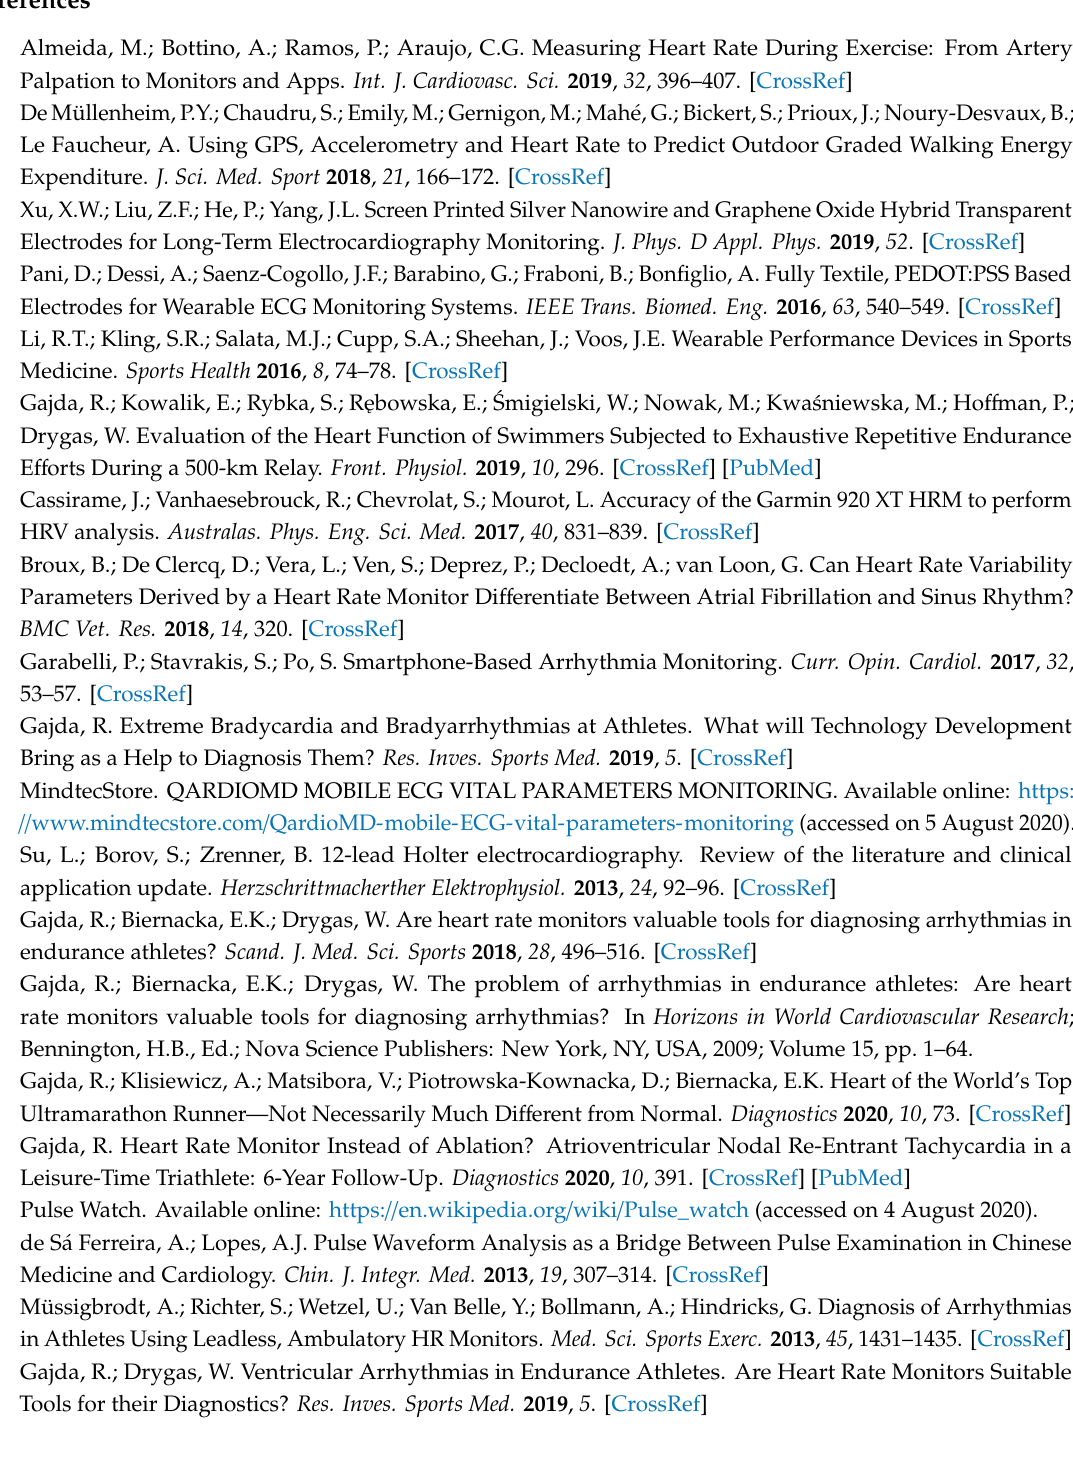
athlete, Table S1.2.2. (B) Doctors—suspected arrhythmia, Table S1.2.3. (A) Athletes—healthy athlete, Table S1.2.3. (B) Athletes—Suspicion of arrhythmia, Table S1.3. Reasons for preferential use of wrist-worn optical heart rate monitors (OHRMs) versus chest strap HRMs (SHRMs) by athletes, coaches, and doctors, assuming that both types of HRM have the same functions and the same resistance to